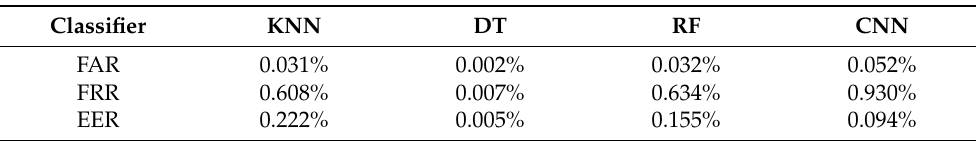
Table 11. CA evaluation—Scenario C: (set of mouse movement and point-and-click actions): FAR, FRR, and